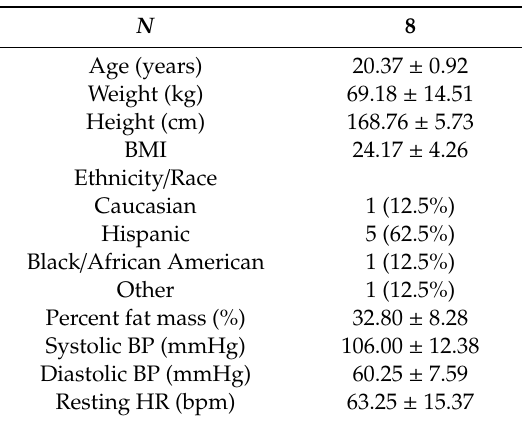
Table 2. Subject characteristics a